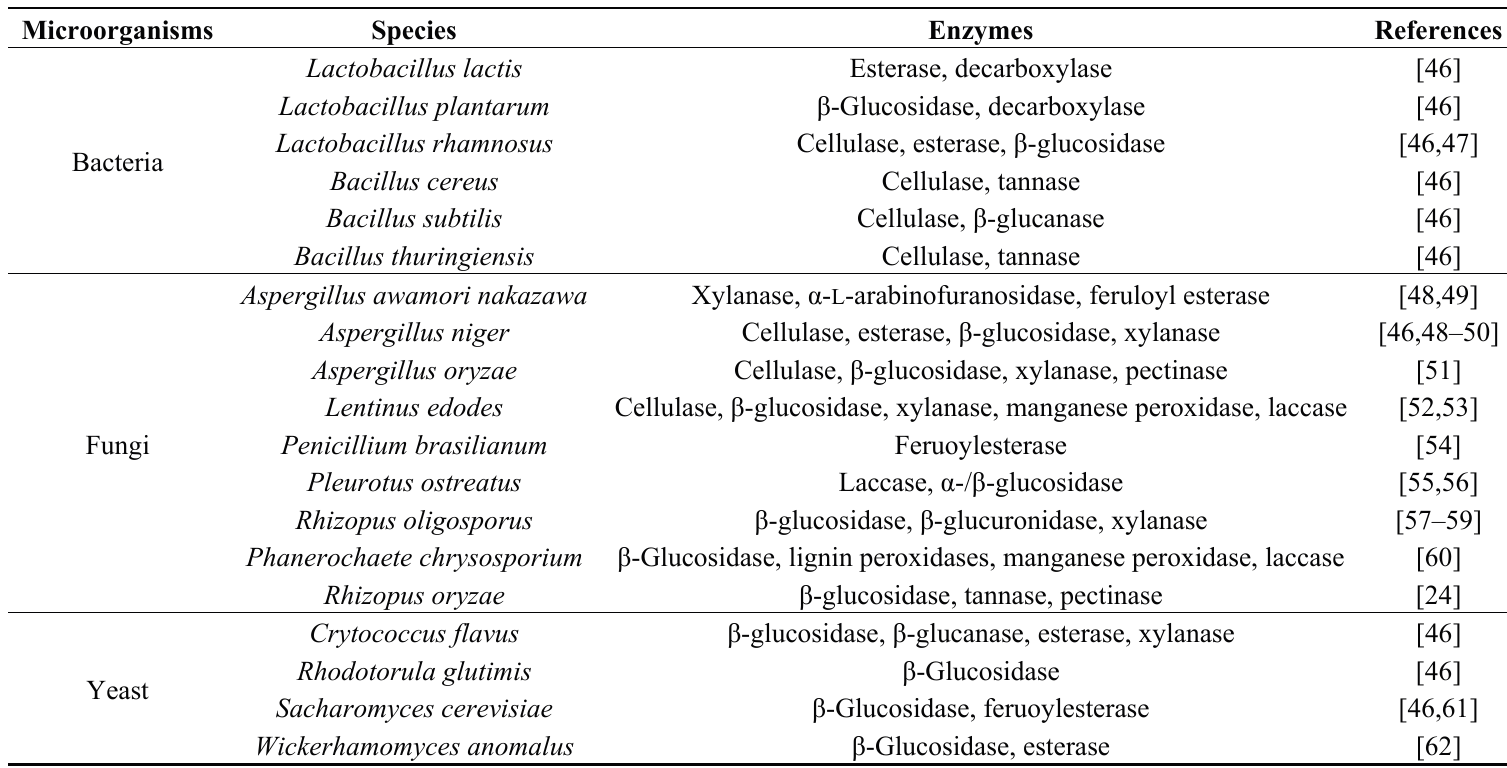
Table 2. Enzymes system produced by different microorganism strains to degrade the cell wall